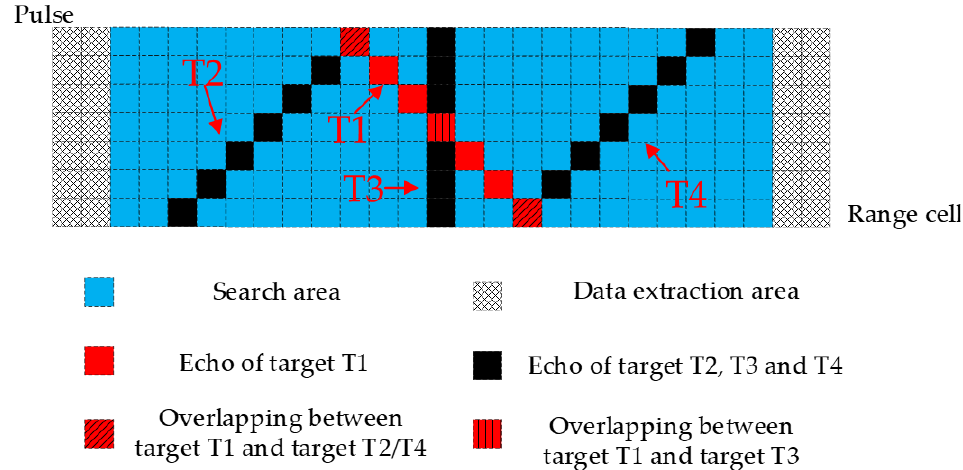
Figure 3. Schematic diagram of indication vector obtained by targets’ motion trajectories overlapping.